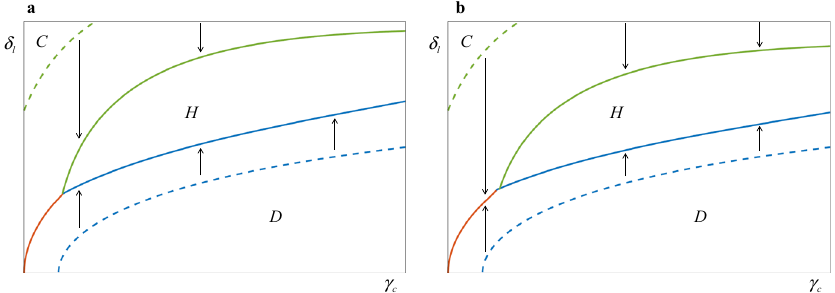
Fig. 7 Comparative statics of optimal institutional design. a Increase in expected asset return. b Decrease in volatility of asset return